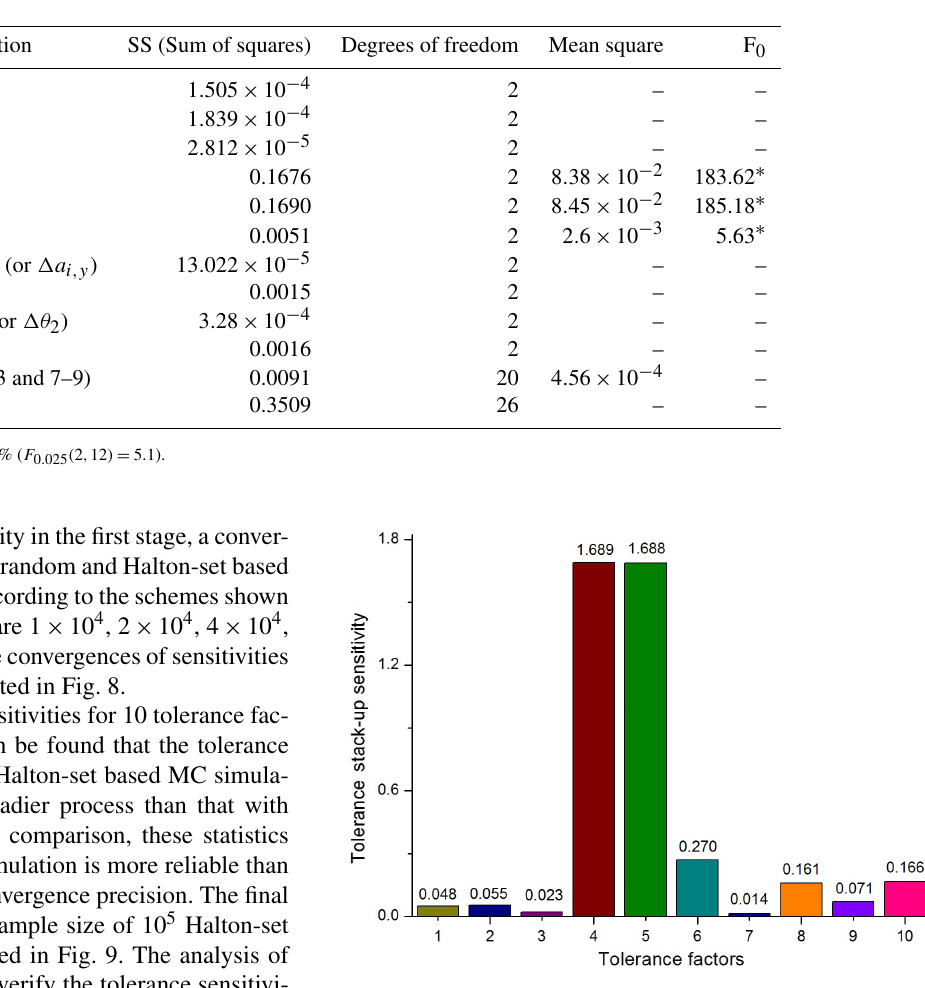
be inversely proportional to their sensitivities. The uniform array of U 20 (4 4 ) is properly enough by accommodating to 4 factors, 4 levels per factor and 20 combinations of levels. The combinations of different levels among factors with distribu- tional regularity and uniformity, have an optimum coverage of the tolerance space, and avoid enumeration that may pos- sibly result in a combination explosion. The levels re-divided for factors (cid:49)γ , (cid:49)a i,z , (cid:49)θ 1 (or (cid:49)θ 2 ) and (cid:49)l are contained